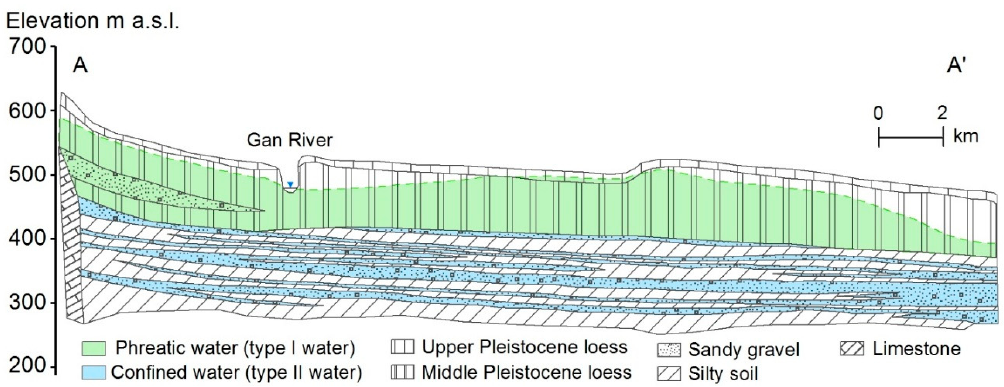
Figure 2. Cross section of loess tableland showing the distribution of phreatic water, confined water, and aquifer lithology.